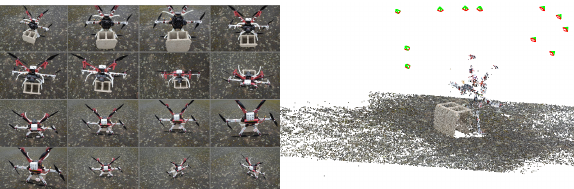
Figure 6: Modelisation of relative position of camera and